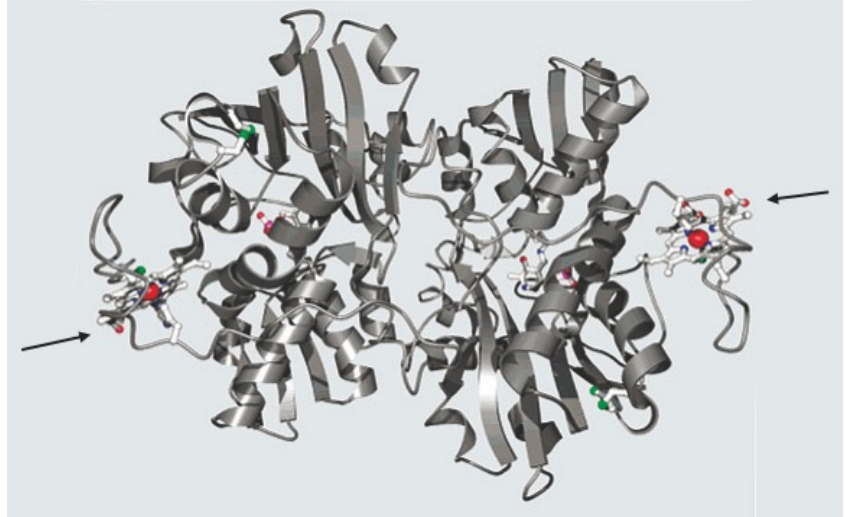
Figure 1. Human cystathionine-ß-Synthase (a Homotetramer): the protein backbone of a dimer is represented as ribbons, while heme (in a pocket, see arrows), pyridoxal phosphate and the so-called CXXC oxidoreductase motif are drawn as ball and stick models. The iron in the porphyrin moiety is shown as a red dot. (adapted from [4]) Copyright 2002 with permission from American Chemical Society). Table 1. Functions of heme in human cellular metabolism.